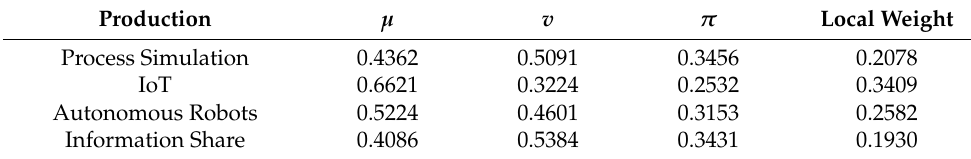
Table 7. Spherical fuzzy and defuzzified weights for sub-criteria of production.